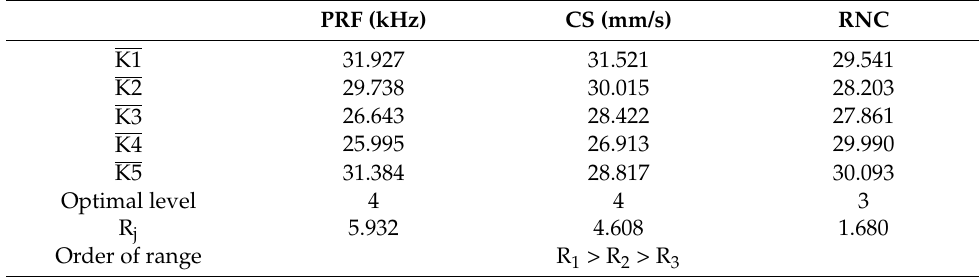
Table 6. Range analysis table based on diameter of the micro-hole. PRF (kHz) CS (mm/s)